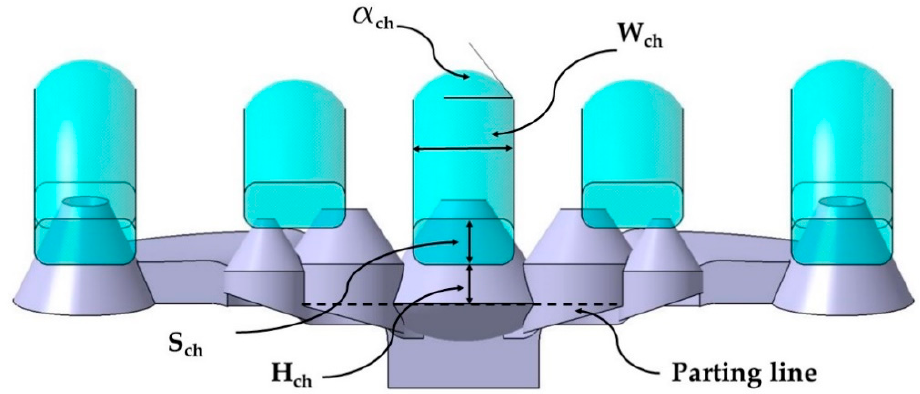
Figure 9. S ch , H ch , a ch and W ch parameters on the design of the new conformal channels.